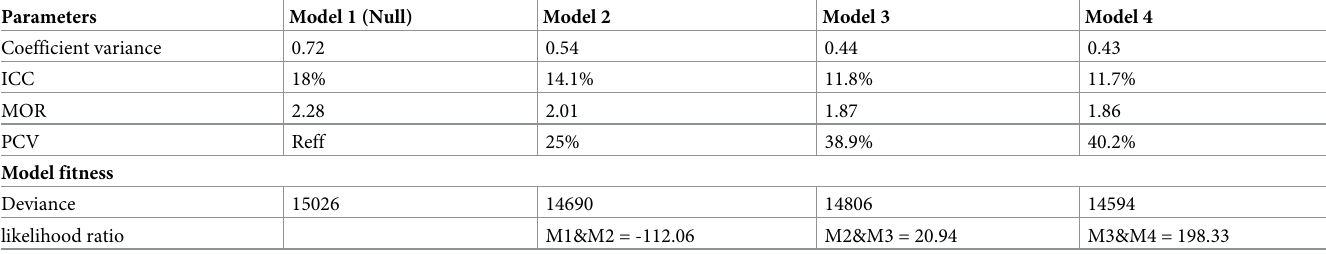
Spatial distribution, incremental and spatial autocorrelation analysis. The spatial dis- tribution of anemia among reproductive-age women in Ethiopia shows significant spatial vari- ation across the country. In Afar, Somali, and Dere Dewa regions have a high prevalence of anemia among WRA whereas B/gumiz, Amhara and SNNPR region had low prevalence “Fig 4”. Anemia among reproductive-age women was shown to be spatially clustered in Ethiopia, Table 2. Parameters and model fit statistics for multi-level models.